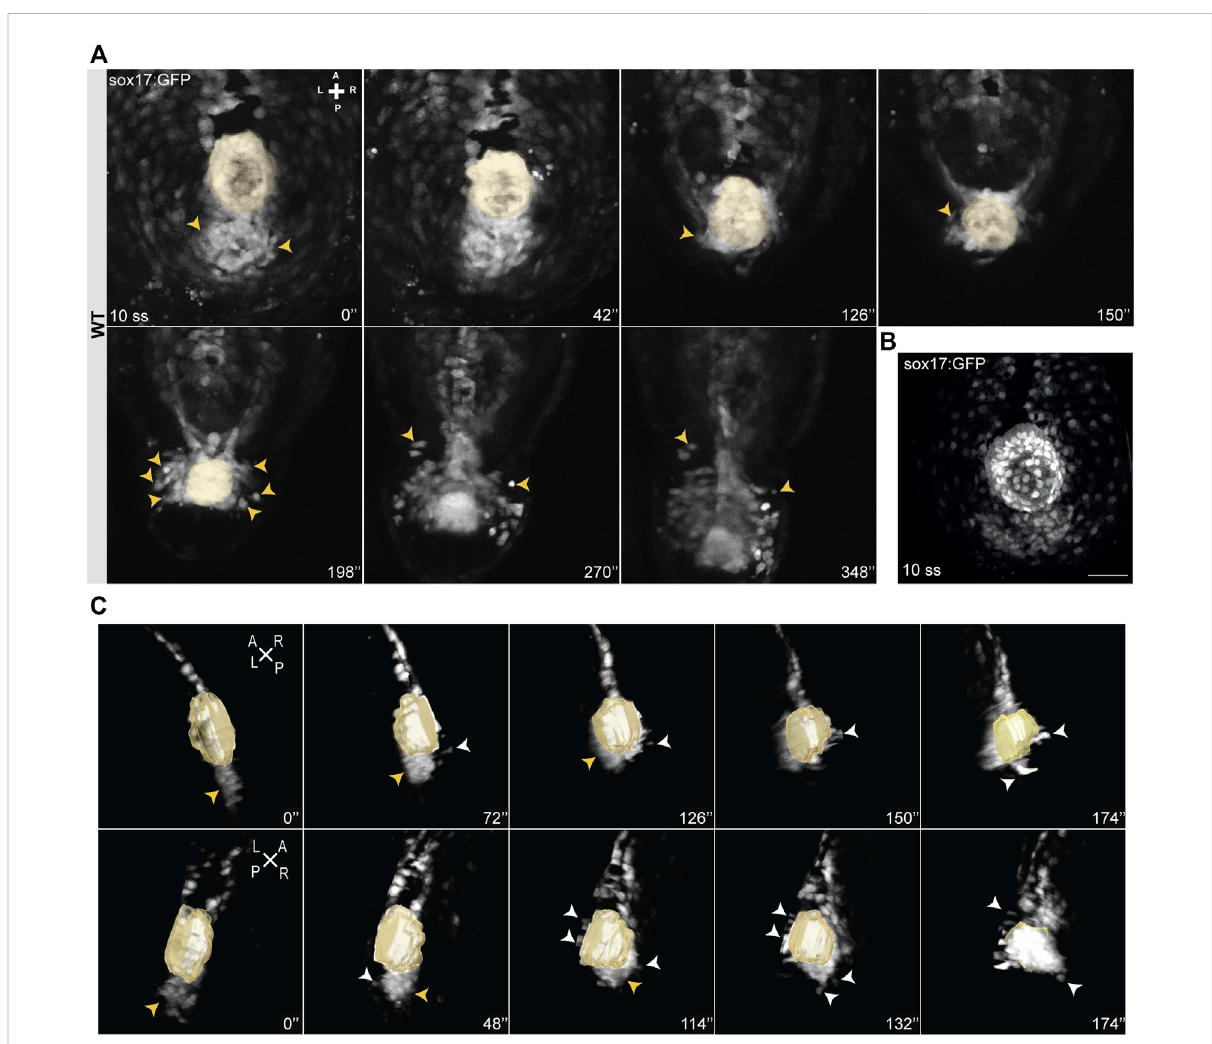
FIGURE 2 Snapshots from time-lapse live imaging of NKSTCs. (A) Time-lapse imaging of a WT Tg (sox17:GFP) embryo, starting at 10 ss, showing NKSTCs movement from a posterior cluster aligned with the KV. NKSTCs are fi rstly indicated by yellow arrowheads in the cluster. In the following snapshots, the yellow arrowheads show the fi rst cells that exit the cluster and migrate towards the anterior side from either the left or right side. (B) Maximum intensity projection of a 10 ss Tg(sox17:GFP) fi xed embryo showing the ´posterior cluster ’ aligned with the KV, scale bar = 50 µm. (C) 3D lateral viewsoftheKVandposteriorclusterat10ss.Left,yellowarrowheads;right,whitearrowheads.Elapsedtimeisindicatedinminutes( ‘ )attherightand axes are indicated: A, anterior; P, posterior; L, left; R, right. N is shown in